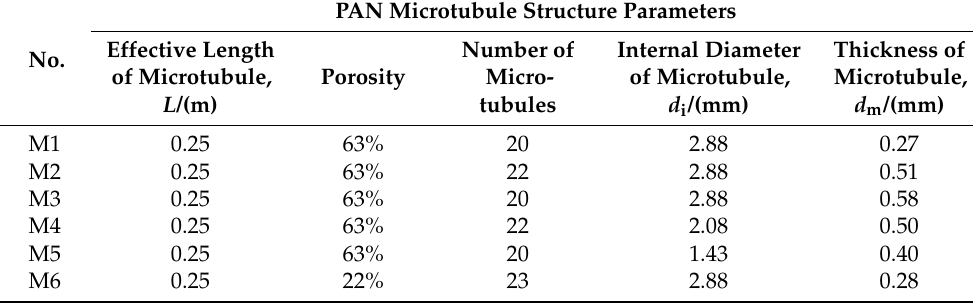
Table 2. Structure parameters of microtubule